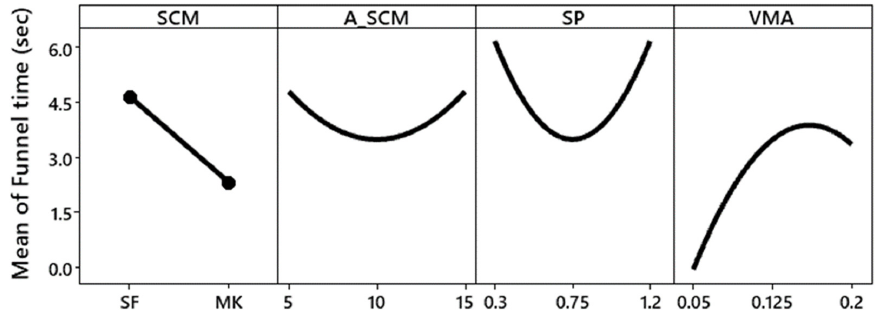
Figure 3. The main effects plot for V-funnel time.